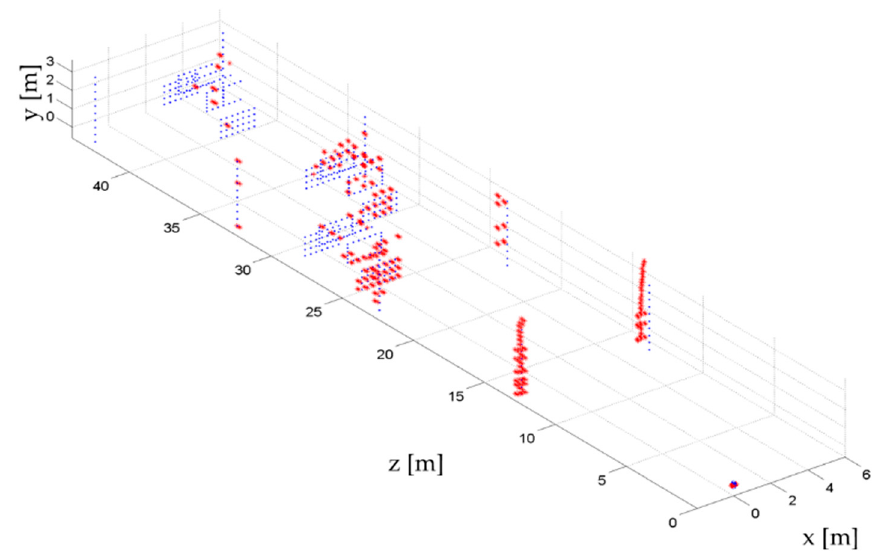
Figure 8. The 3D reconstruction of the realistic scenario. Blue dots represent reference target positions, whereas the red dots are the estimated targets.